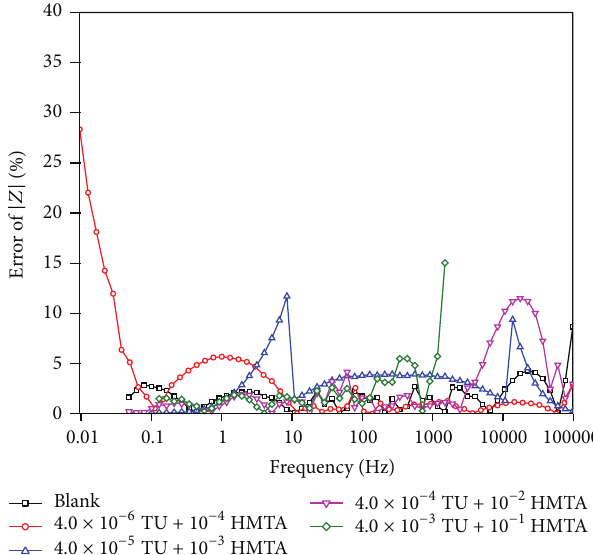
Figure 5: Measurement and fitting error of |𝑍| for N80 after exposure to four different solutions at open circuit potential and 25 ± 1 ∘ C.